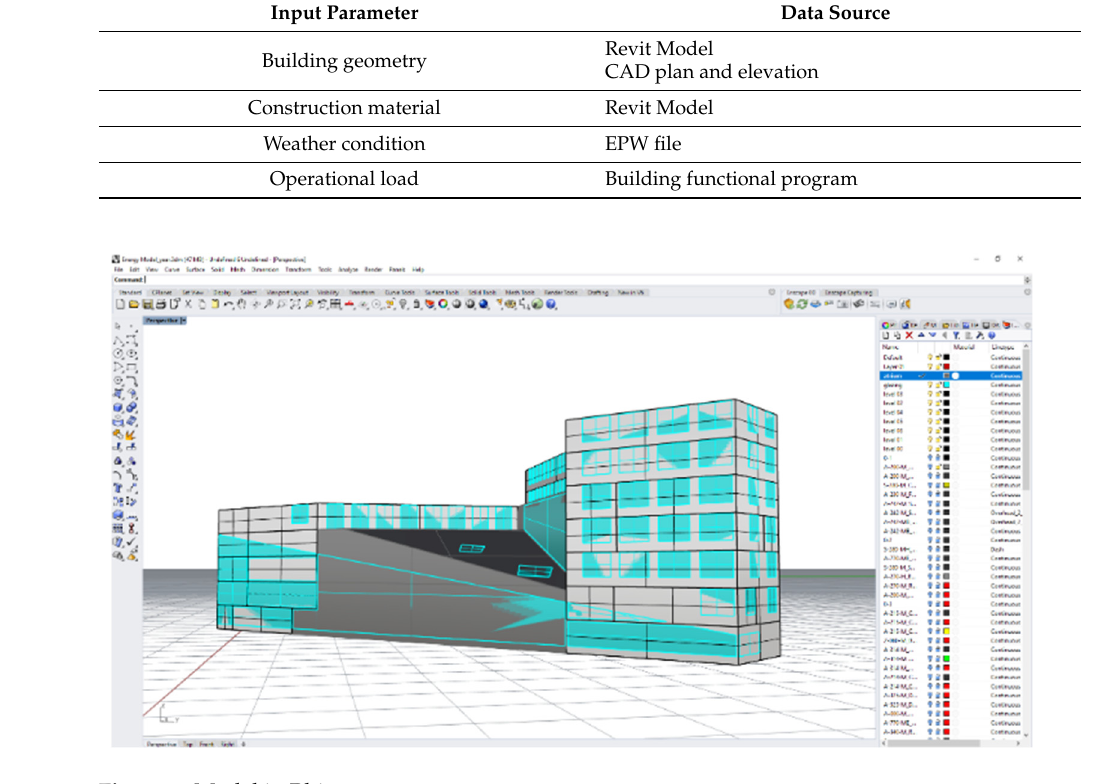
Figure 3. Model in Rhino.